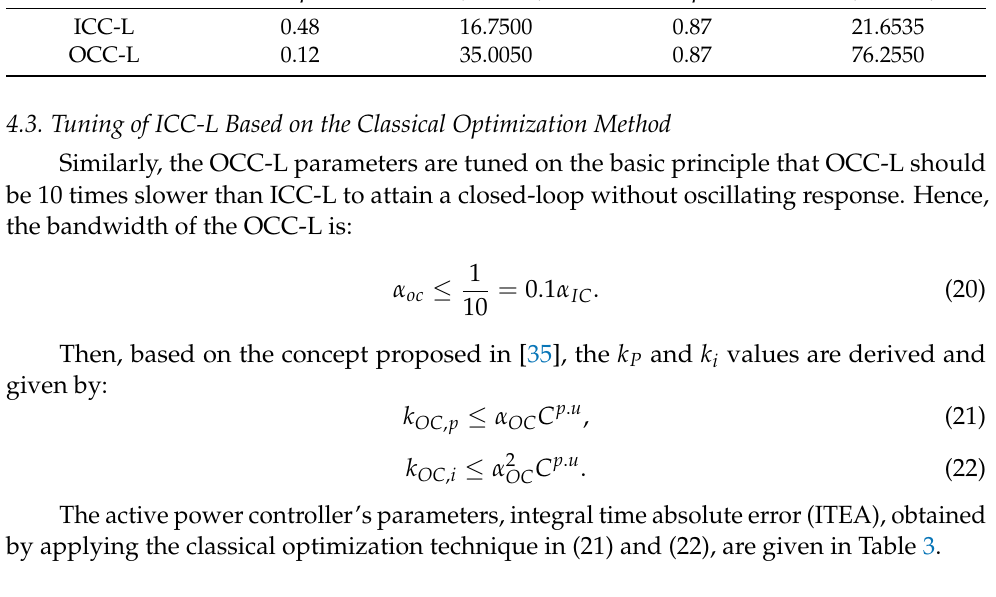
Table 3. Comparison of ABC and classical tuned P-I controllers in terms of integral time absolute error